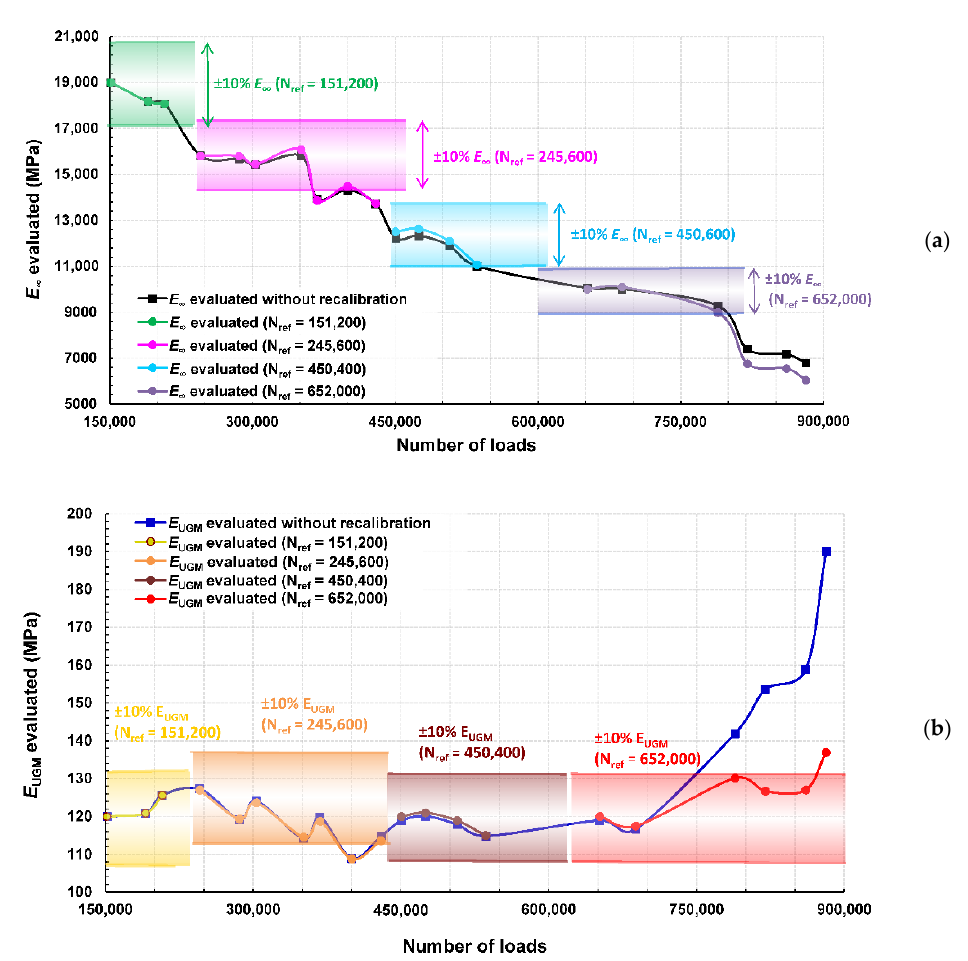
Figure 13. Evaluation of E ∞ and E UGM as a function of loadings through the OIM with recalibration steps proceeding at numbers of loadings labeled as N ref with ± 10% variation windows ( a ) for E ∞ and ( b ) for E UGM .